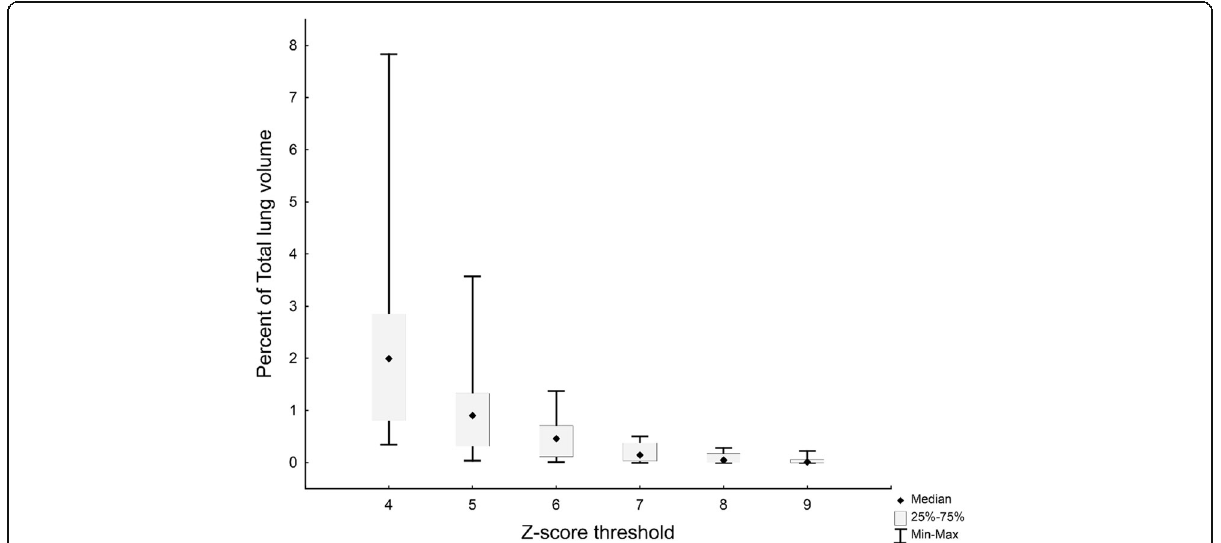
Fig. 3 The range, median and 25th and 75th percentiles for percentage of total lung volume classified as FDG avid at different Z -score thresholds [4 – 9], in the quantification of PET-CT scans from 15 controls with visually lesion-free